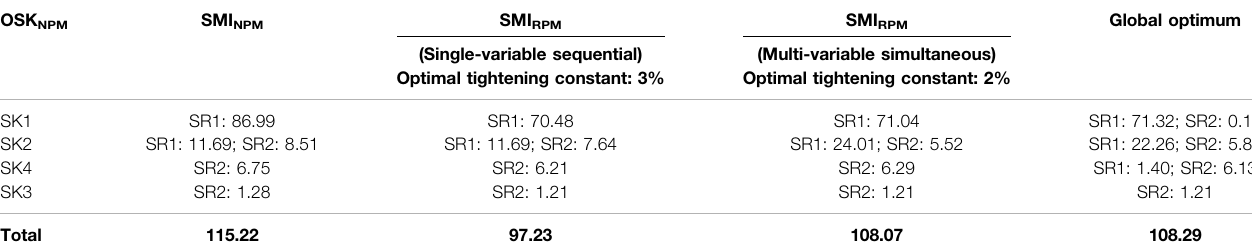
TABLE3| SMI NPM ,SMI RPM andglobaloptimumresultsforthecasestudy-1.Foreachsinktherespectivesourcesrecyclingtothatsinkareshown.Theresultsforthesingle- variable sequential and multi-variable simultaneous recycling maximisation approaches at each process sink selection step are reported at their optimal tightening constant values. The reported values refer to kmol/batch. MAI of the fi rst sink is 5% mol/mol.